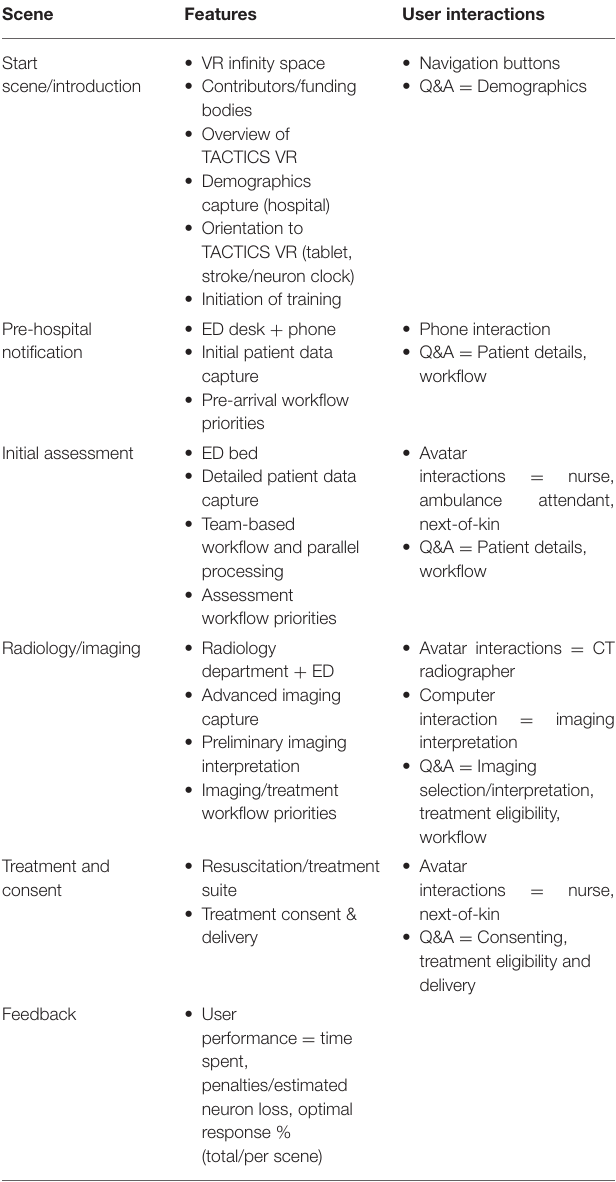
TABLE 1 | TACTICS VR scenes, key features and user interactions. Scene